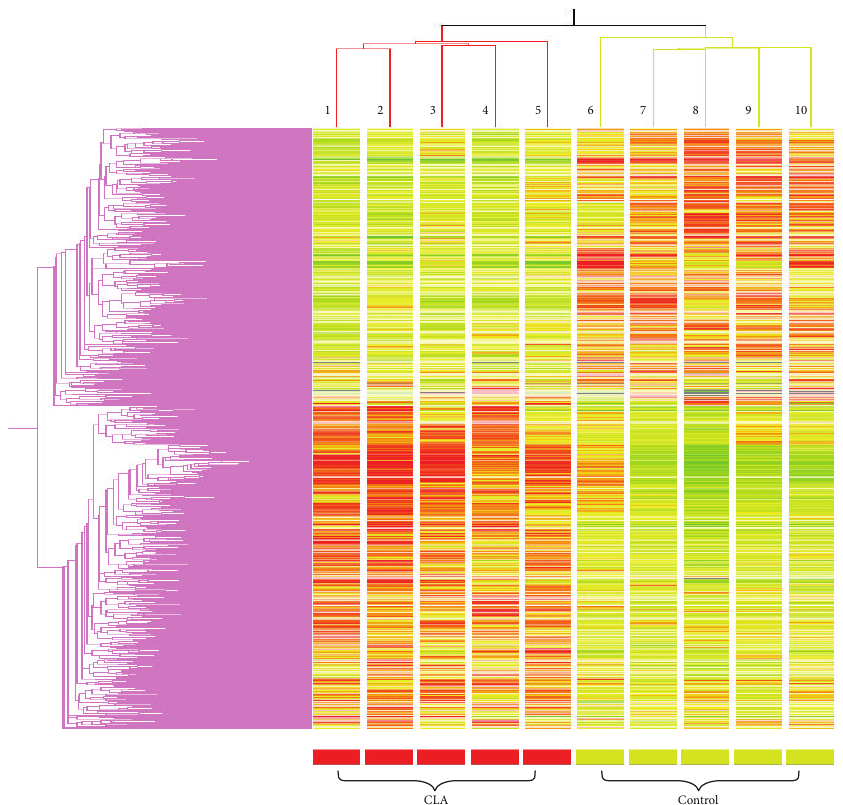
Figure 1: Hierarchical clustering analysis of DEG (1,496) in mammary tissue from individual lactating mice fed trans -10, cis -12-CLA (CLA) or the control diet (CTR). The colors of the heat map represent the expression of each DEG in mammary tissue versus reference, with red, green, and the various hues denoting greater (red) to lower (green) relative expression (tissue/reference). The average Pearson correlation across animals in the CLA group was 0.38 and for those in the CTR 0.41. The numbers represent an individual mouse within the CLA or CTR group. The clustering by gene is denoted by the pink tree on the left of the